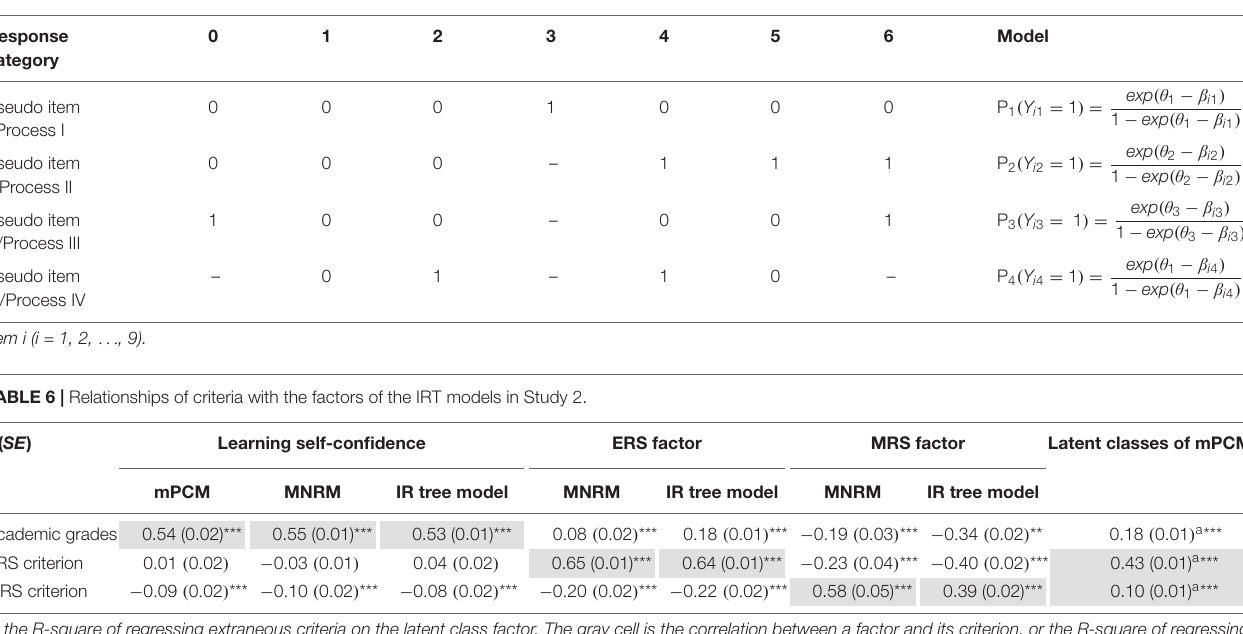
TABLE 5 | Decomposition of learning self-confidence items into pseudo items.